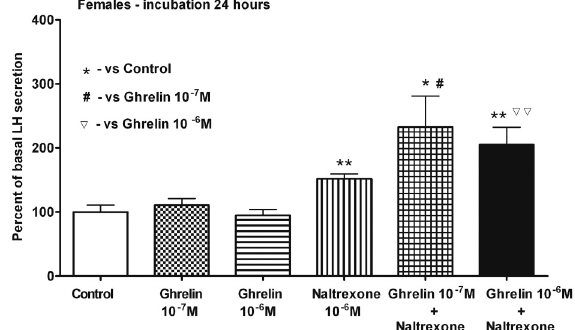
Fig. 2. Percentage of basal LH secretion from female pitu- itary cells incubated for 24 h with control medium,